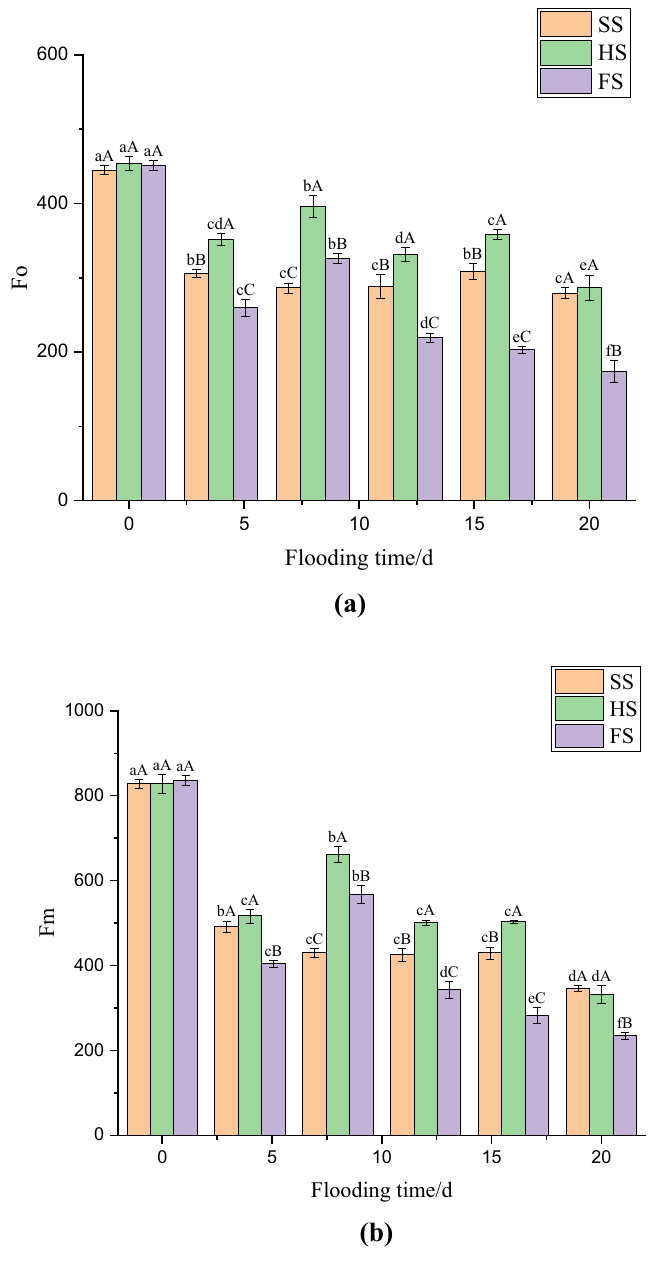
Figure 2. Effect of submergence stress on Fo and Fm in Morus alba. Different uppercase letters indicate that the means of the different groups at the same time are significantly different ( p < 0.05), and different lowercase letters indicate that the means of the same group at different times are significantly different ( p < 0.05). This figure was drawn using Origin Pro 2021 v.